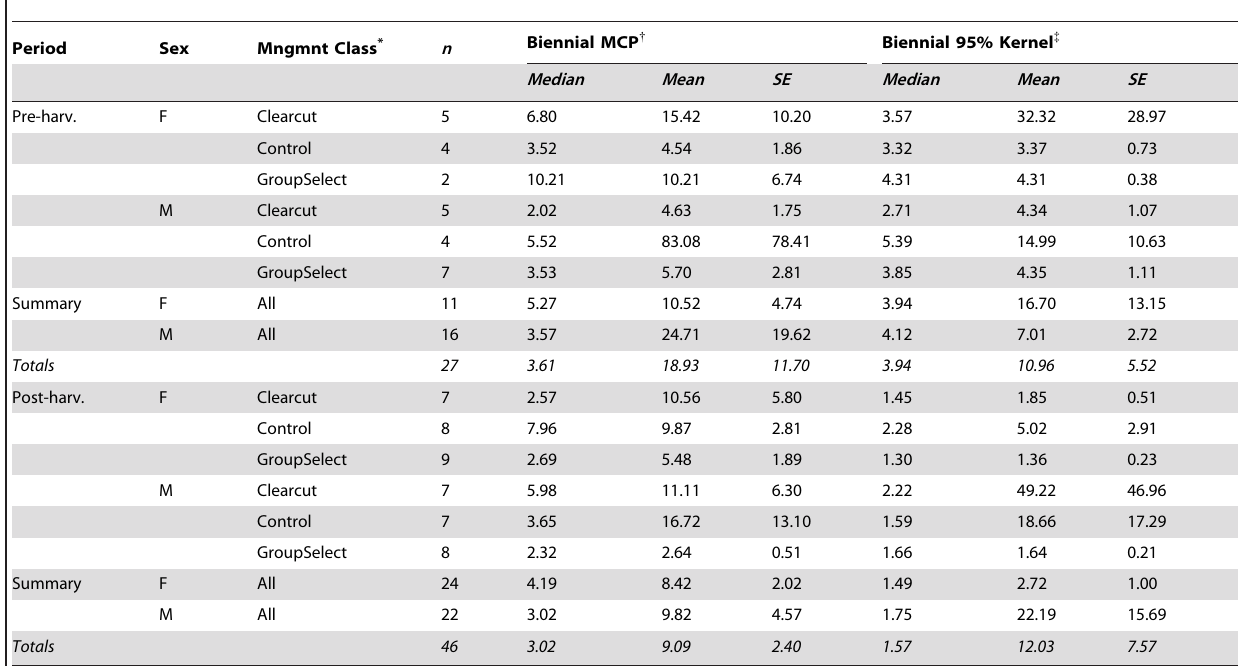
Table 1. Pre-harvest (Pre-harv.; 2007–2008) and post-harvest (Post-harv.; 2009–2010) home ranges of female and male eastern box turtles.